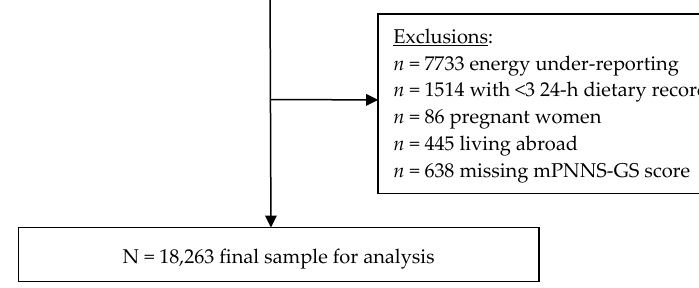
Figure 1. Participant selection flowchart.